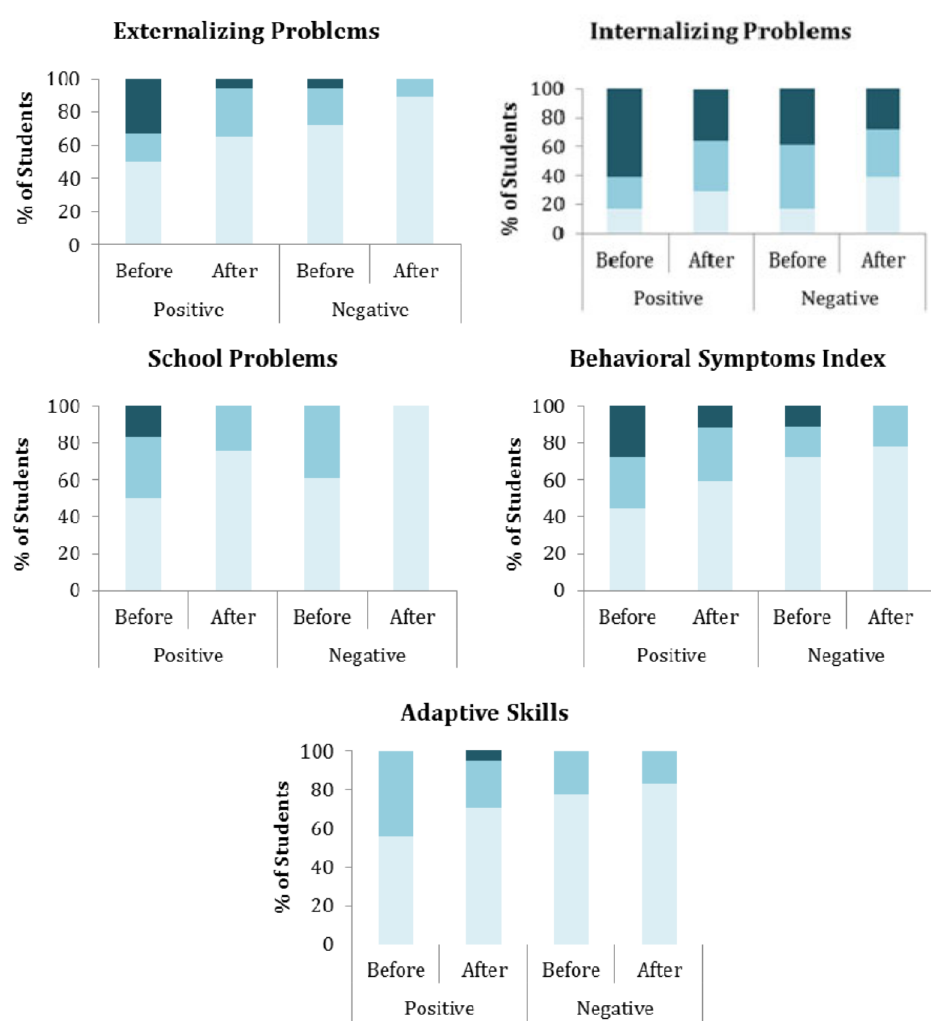
Fig 2. Percent of students with average,at-risk, or clinically significant BASC-2 T scores. Percentages were calculatedfor S . mansoni egg-positiveand egg-negative students both before and after treatment. Color intensity represents the category: dark blue = clinicallysignificant;medium blue = at-risk; light blue = average.